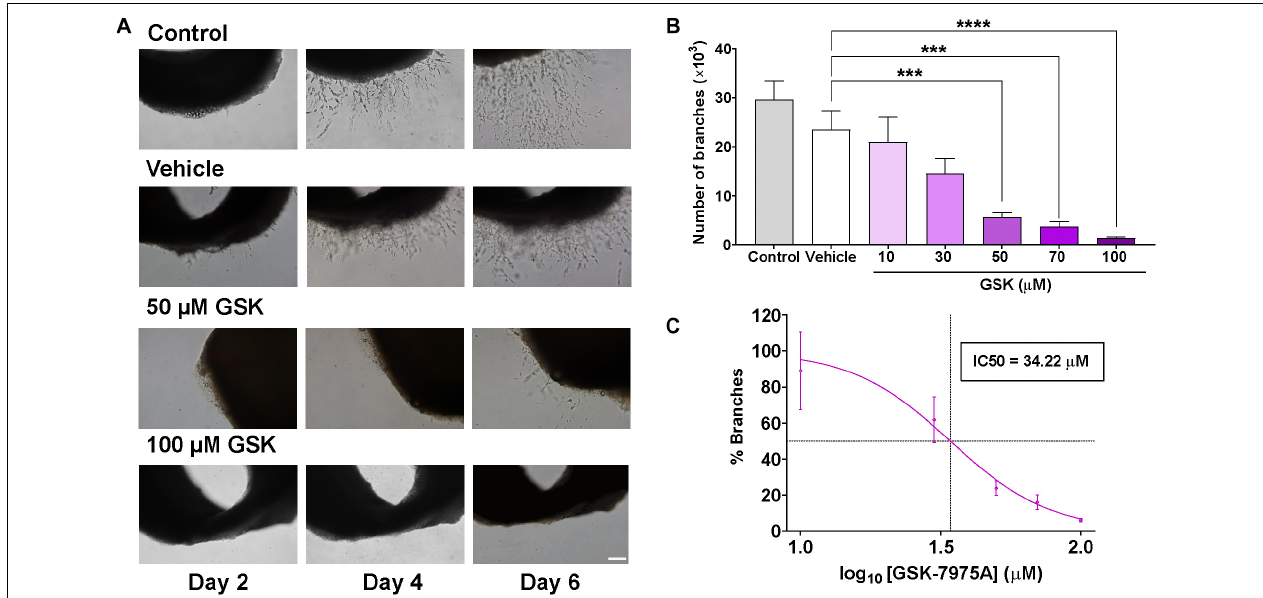
FIGURE 1 | SOCC inhibition by GSK-7975A reduces aorta sprouting. Aorta was cultured in the endothelial cell culture medium (EGM-2) enriched with growth factors. (A) Phase-contrast imaging ( × 10 objective; scale bar = 200 µ m) shows sprouting of aorta rings on day 2, 4, and 6 in untreated aorta (control), in aortic ring treated with DMSO (Vehicle), and in aortic rings incubated with GSK at 0, 50, and 100 µ M. (B) Bar graph shows the number of branches in control rat aorta rings (gray) and in aorta treated with vehicle (DMSO; white) and with 10, 30, 50, 70, and 100 µ M of GSK (purple) ( n = 6). (C) Curve shows the dose-dependent inhibition of % branches mediated by GSK-7975A in the rat aorta ring assay. IC50 = 34.22 µ M. The fit was done using Hill equation as described in Methods (Hill slope: − 2.443, 95% CI IC50 22.86 to 44.85, R 2 = 0.5762). Values are presented as means ± S.E.M. (***), and (****) indicate significance with p < 0.01, and p < 0.0001,